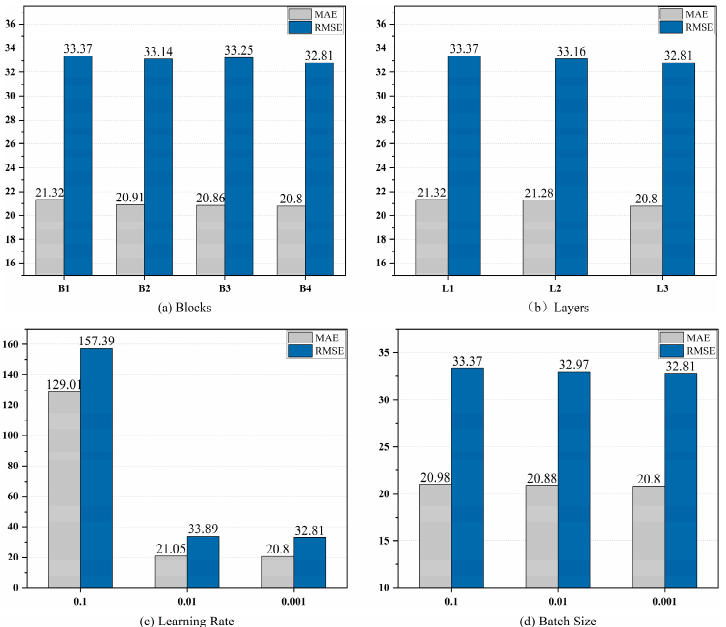
Figure 13. Network configuration analysis. In ( a ), B1 represents the network configuration with one T-GACN module, and the number of other modules increases sequentially. In ( b ), L1 represents the network configuration with one T-GACN layer, and L3 represents the network configuration with three T-GACN layers. ( c , d ), respectively, analyze the effects of learning rate and batch size on the network.